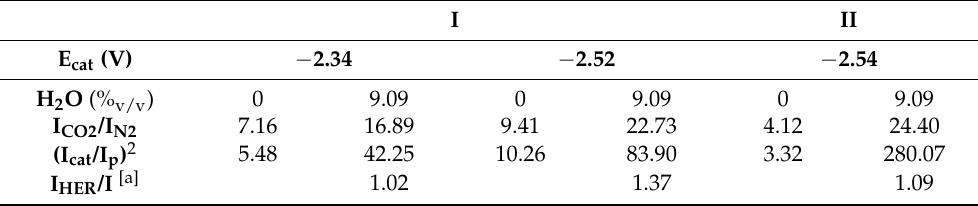
Figure 4. CVs of complex I under N 2 ( a ) and under CO 2 ( b ) at different water amounts. In Table 3, a comparison between the current enhancements ( I CO2 /I N2 ) upon 9.09% v/v water additions, calculated at two different potentials ( − 2.34 V and − 2.52 V) under both 9.09% of H 2 O of compound I (16.89 and 22.73), with those of complex II (24.40), it comes to presence of water it shows a slightly smaller current enhancement with respect to II . Table 3. I CO 2 /I N 2 and (I cat /I p ) 2 values summary for complexes I and II under anhydrous conditions and in the presence of water calculated at the corresponding potentials.